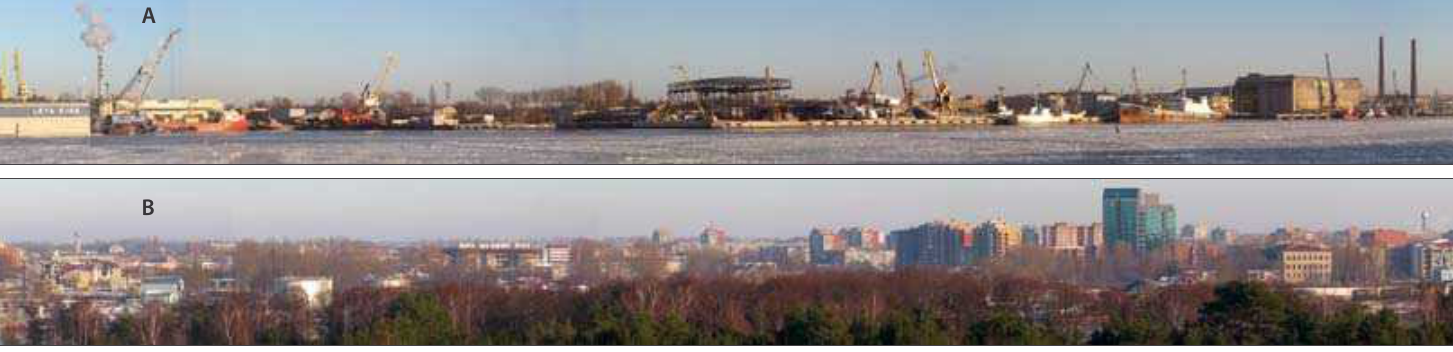
dėl lygaus reljefo Klaipėdoje nėra daug natūralių (gamtinių) apžvalgos taškų. Visą miesto panoramą įmanoma apžvelgti tik iš Smiltynės, todėl planuojant svarbu įvertinti pasekmes marių išklotinėje (9 pav.). Taip pat nėra vertikaliųjų akcentų išdėstymo